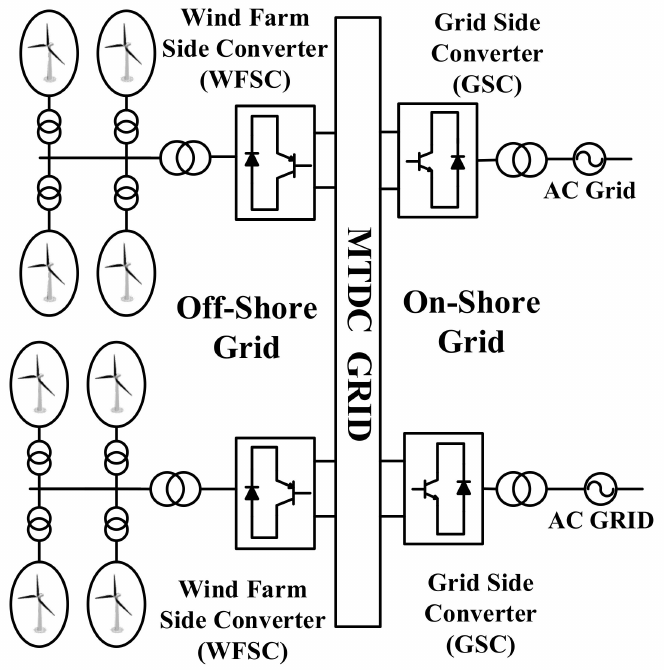
Figure 1. Typical multi-terminal HVDC (MTDC) network